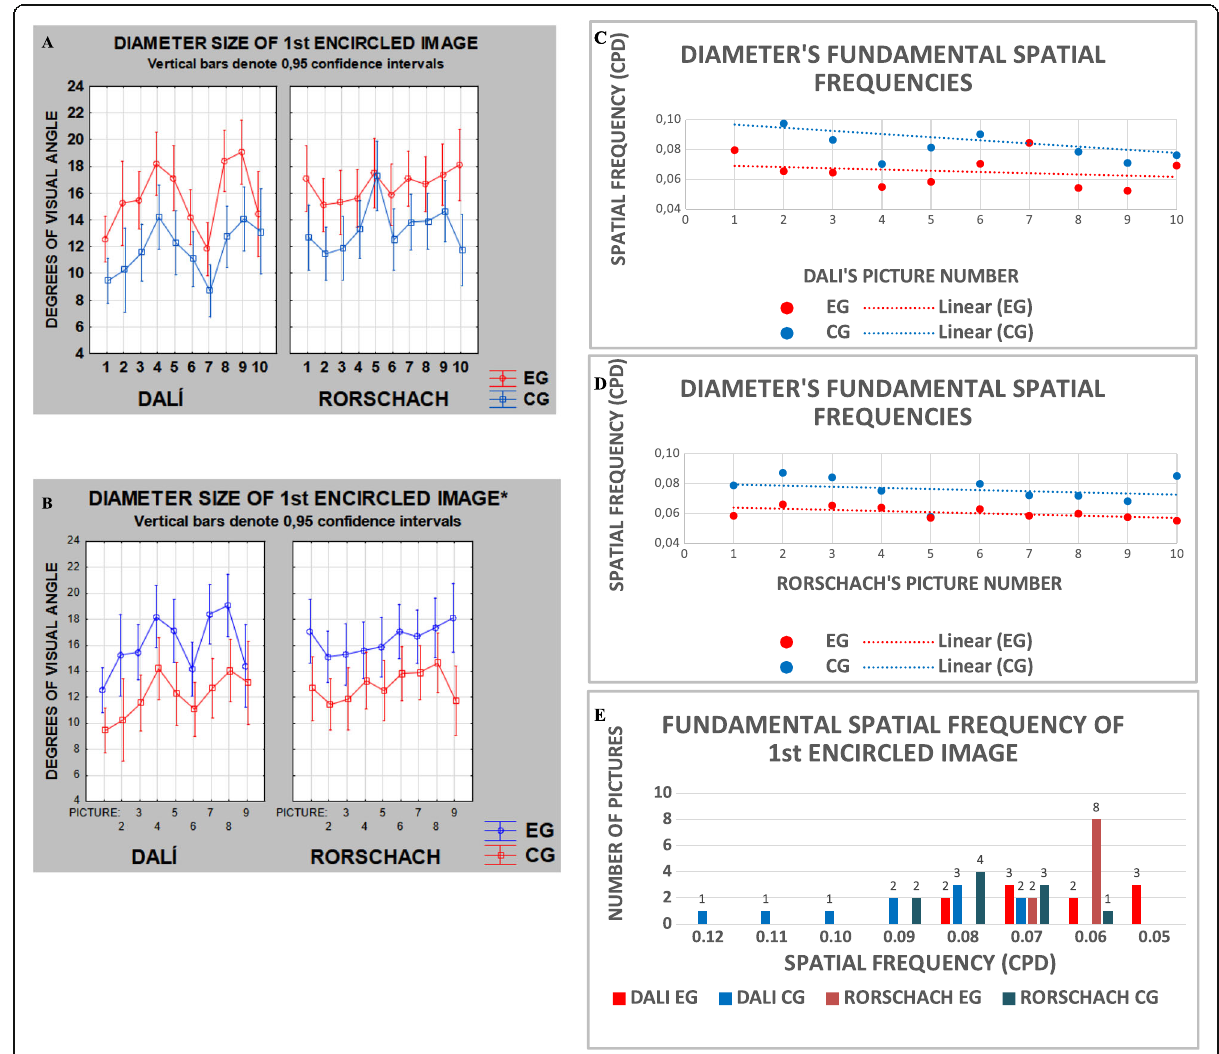
Fig. 4 Diameter size of 1st encircled image for Dalí and Rorschach stimuli by group ( A ). Diameter size of 1st encircled image for Dalí without number 7 and Rorschach without number 5 ( B ) for EG and CG. Differences between groups were significant in both cases. Fundamental Spatial Frequencies for both Dalí ( C ) and Rorschach ( D ) pictures. Notice the parallelism of the linear tendency lines ( C , D ). Observe that most of the FSF for EG are in the range of 0.06 – 0.07 cpd, spatial frequency contrast sensitivity values yet to be measured and reported in the literature ( C , D